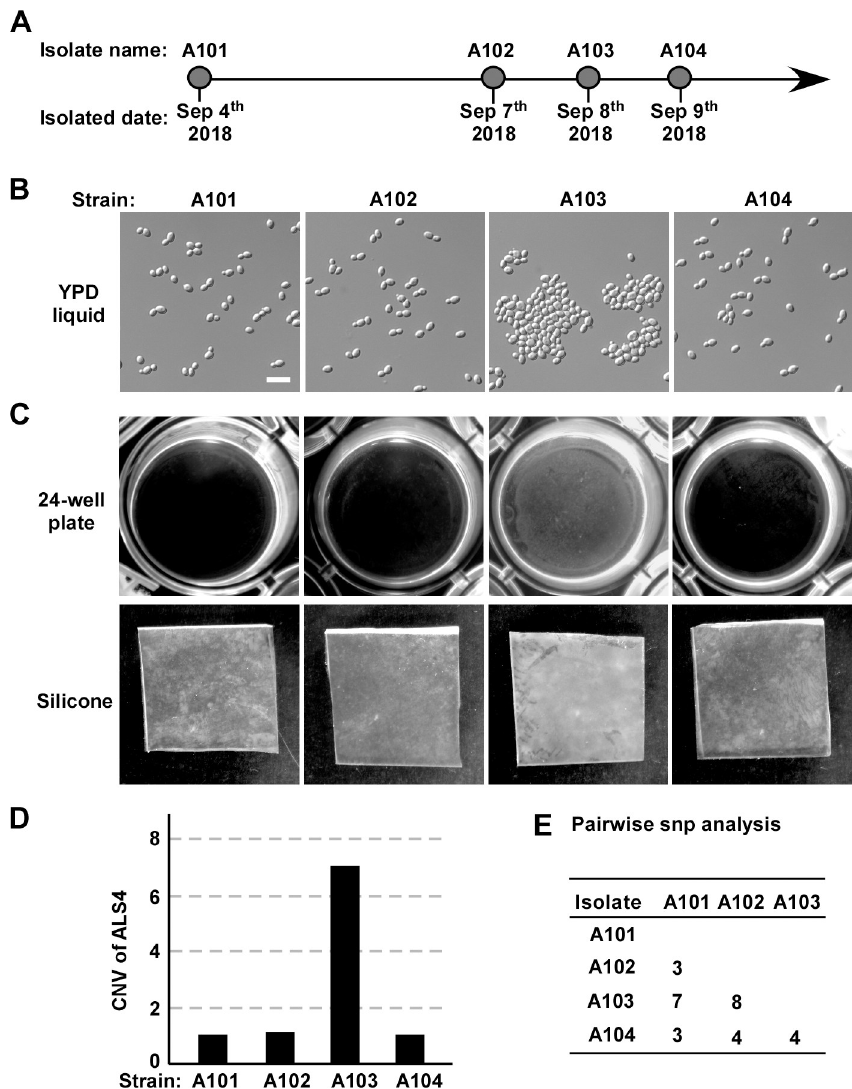
Fig 10. Identification of C . auris strain A103 with enhanced adherence and biofilm formation. (A) Four C . auris strains were isolated at different time points from the same patient. (B) Cellular morphologies of strains A101, A102, A103, and A104. C . auris cells were cultured in liquid YPD medium at 30˚C for 24 hours. Scale bar, 10 μ m. (C) Biofilm formation of the four C . auris strains on the bottoms of 24-well polystyrene plates and silicone squares. C . auris cells were incubated in RPIM1640 medium for 48 hours with shaking at 37˚C. (D) Copy number variations (CNVs) of ALS4 of the four isolates. SRA database accession numbers for the genomic sequences: A101 (SRR9316791), A102 (SRR9316792), A103 (SRR9316793), and A104 (SRR9316794). (E) Pairwise SNP analysis among the four clinical